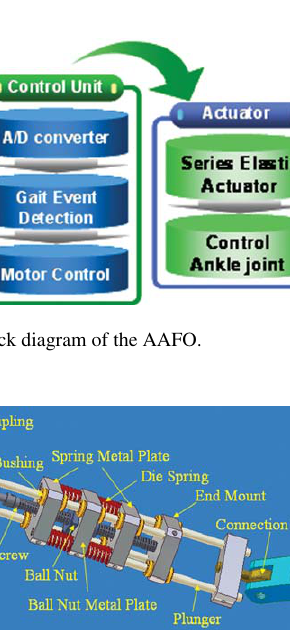
Fig. 2. Series elastic actuator